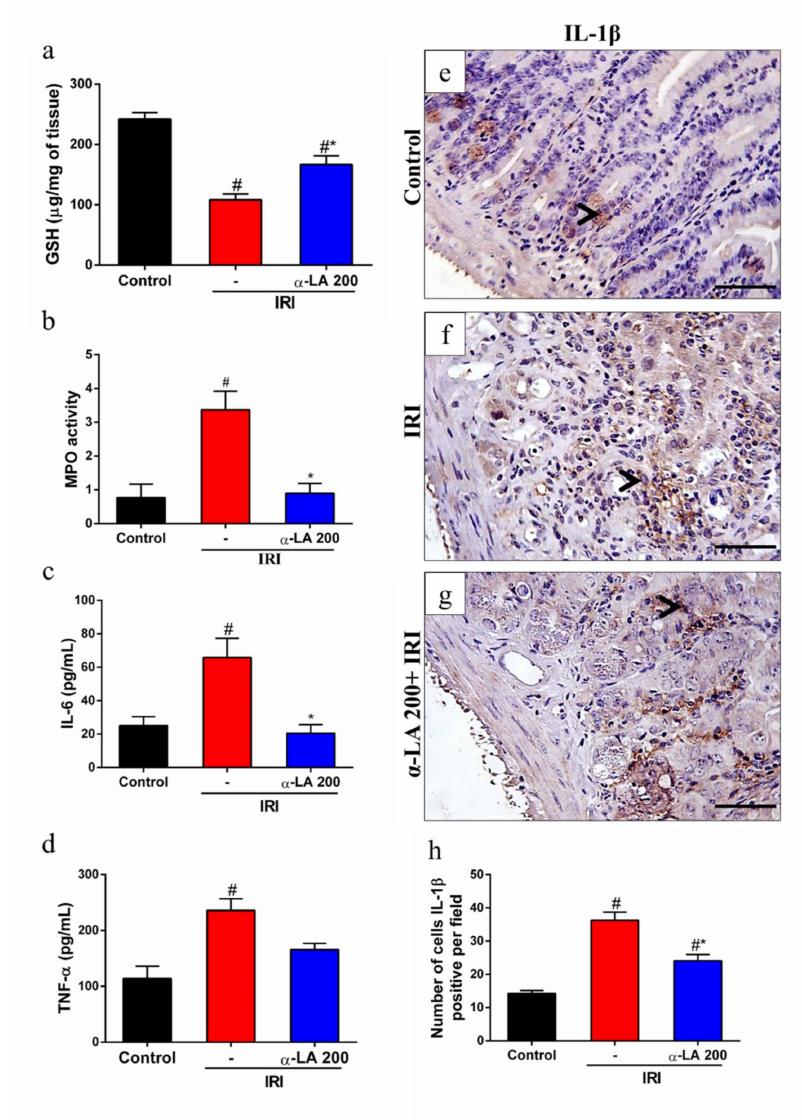
Figure 3. α -LA pretreatment decreases irinotecan-induced duodenum inflammation in mice. Levels of reduced glutathione (GSH) ( a ) and myeloperoxidase (MPO) ( b ) were evaluated by colorimetric assay, and levels of IL-6 ( c ) and TNF- α ( d ) were assayed by ELISA from duodenum samples of mice with irinotecan-induced intestinal mucositis that received α -LA treatment or no treatment. ( e – g ) Representative immunohistochemistry staining for IL-1 β in sections of the duodenum of the control ( e ), IRI ( f ) and α -LA + IRI ( g ) groups. Black arrows point to IL-1 β -positive cells. Scale bars = 50 µ m and magnification: 400 × . ( h ) Bars represent ± SEM of the number of IL-1 β -positive cells per field ( n = 4). # represents p < 0.05 versus the control group, and * indicates p < 0.05 versus the IRI group. One-way ANOVA followed by Bonferroni’s